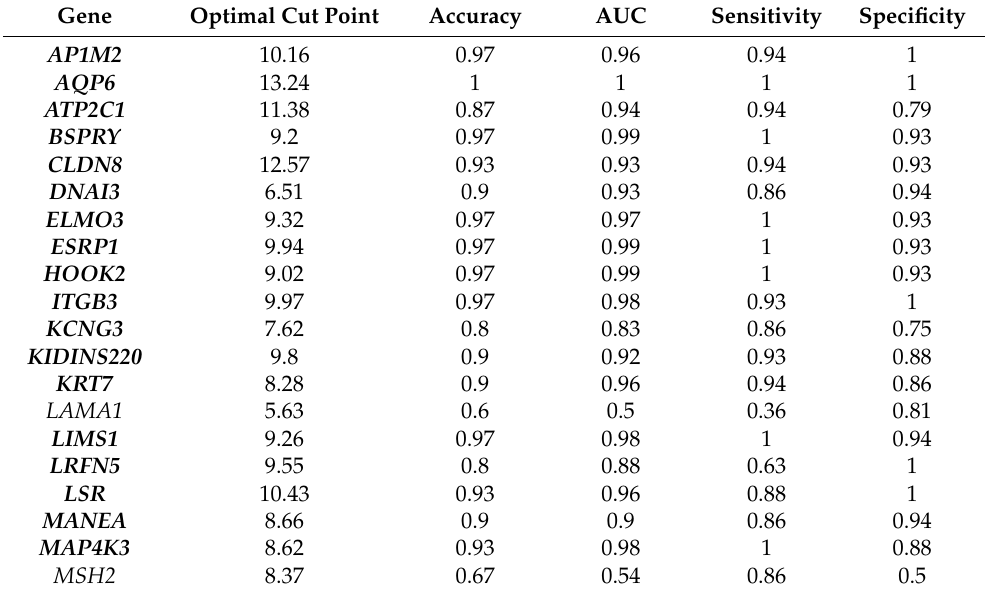
Table 2. Univariate analysis of chRCC and RO NanoString Data. All values were calculated at the optimum cut point between chRCC and RO count